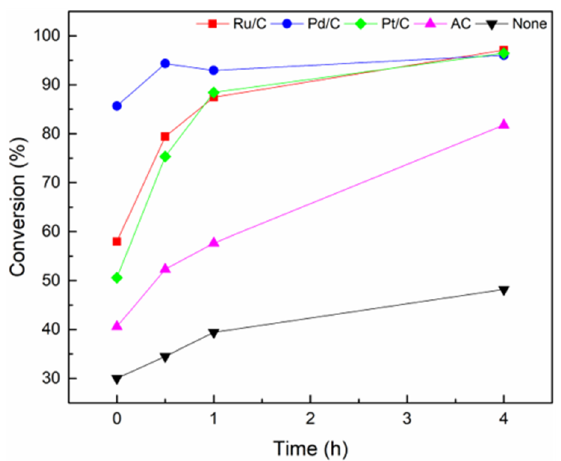
Figure 2. The conversion of BPE over various catalysts at 270 °C in supercritical ethanol as a function of reaction of reaction time.